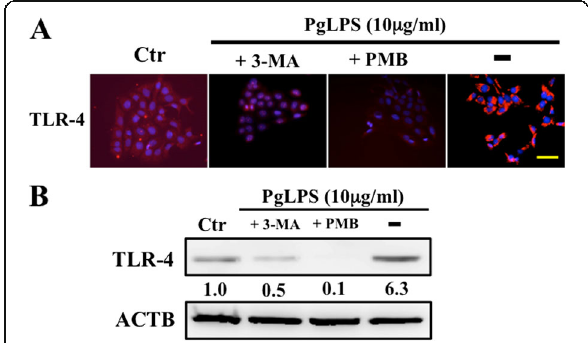
Fig. 7 Induction of autophagy is dependent on TLR4 expression in PgLPS-stimulated HaCaT cells. HaCaT cells were stimulated for 24 hours in the absence (control, Ctr) or presence of PgLPS (10 μ g/ml) with or without 3-MA (10 mM) or PMB (100 μ g/ml). a Representative images of immunocytochemical expression of TLR-4 (Red) in HaCaT cells. Nuclei were stained with Hoechst 33342 (blue). Bar=25 μ m. b Western blotting analysis of TLR-4. β -actin (ACTB) was used as a loading control. Band densities were presened as antibodies ’ expression fold-increases (normalized to ACTB) and compared with the results for untreated cells (Ctr). Quantification results are shown below the corresponding blots. All experiments were performed in